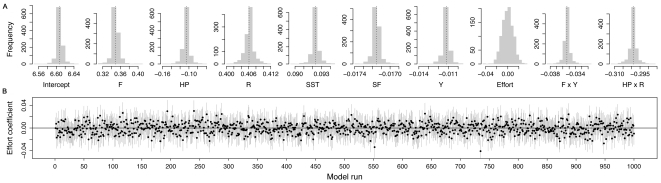
Simulation results.(A) Histograms of estimates of the coefficients with simulated effort included as a new covariate from the model runs as described in ‘Sensitivity analyses’ subsection. The vertical dotted lines indicate the estimates obtained using the model that does not include simulated effort (see specific values in Table 1). Abbreviations are described in the main text. (B) Value of effort coefficient and 95% CI in each model run. This coefficient is statistically significant if the CI does not include zero.